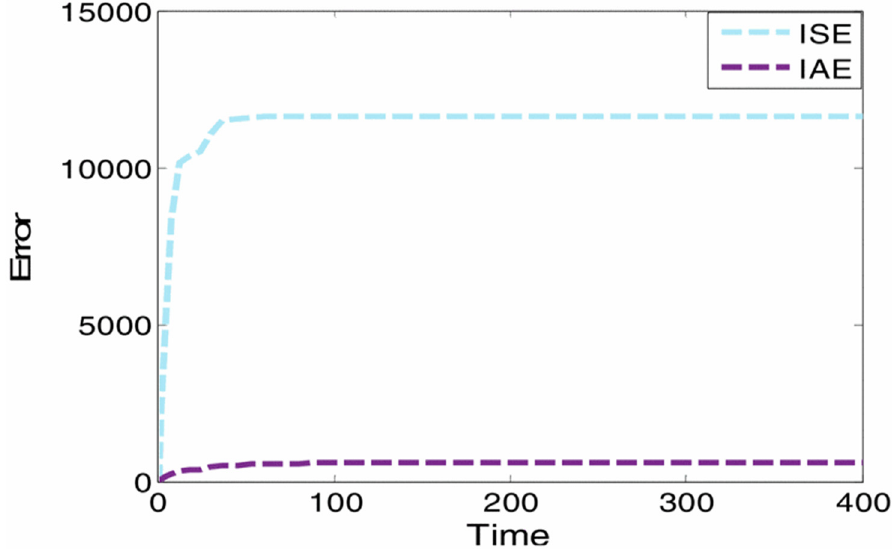
Figure 10. Error response plot of an ambulance with GA PID in terms of time and error.